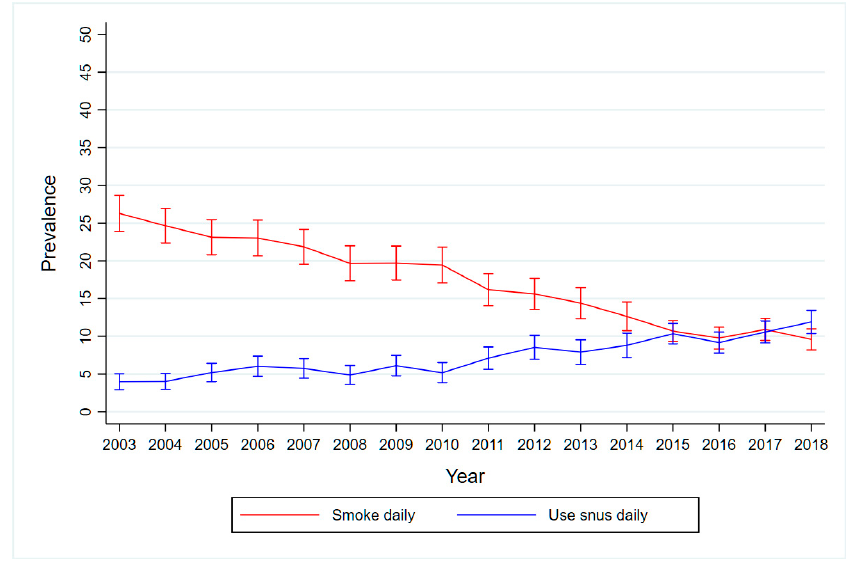
Figure 1. Unadjusted prevalence of daily smoking and daily use of snus among Norwegian adults ages 16–79 years, 2003–2018.